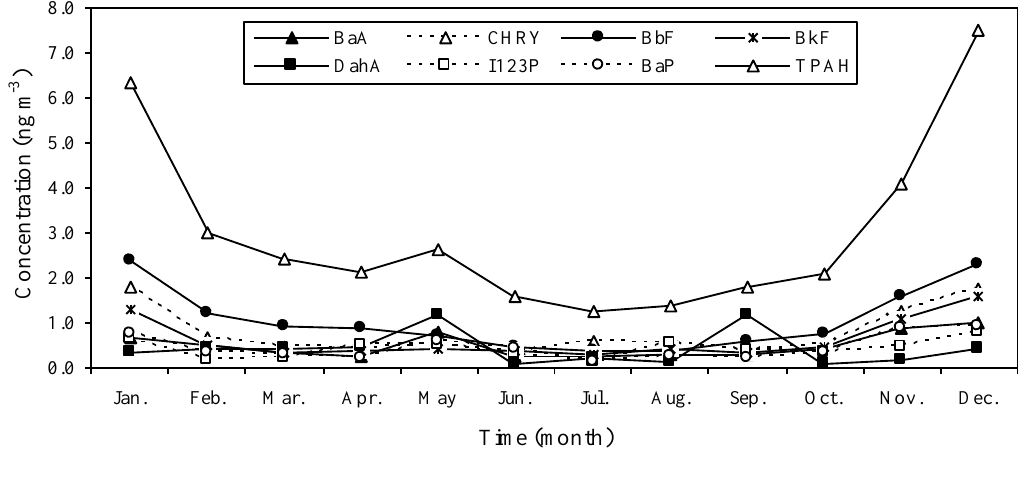
FIGURE 4. The monthly variation of the PAH concentrations for all seven cities and eight provinces during the entire study period.